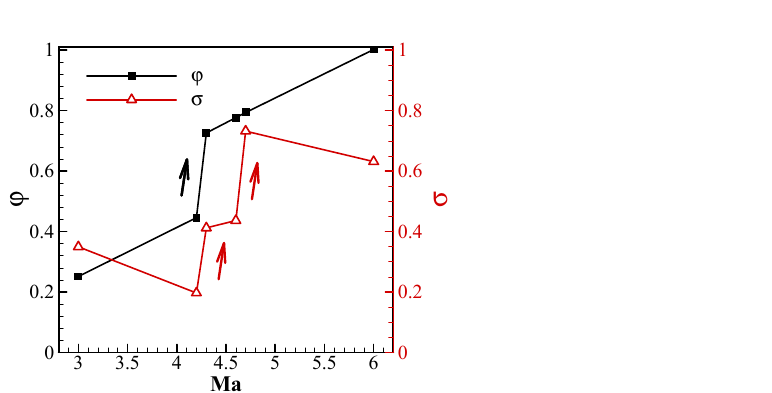
Figure 9. Distributions of mass flow ratio and total pressure recovery coefficient during the second type of starting process ( δ = 10°).